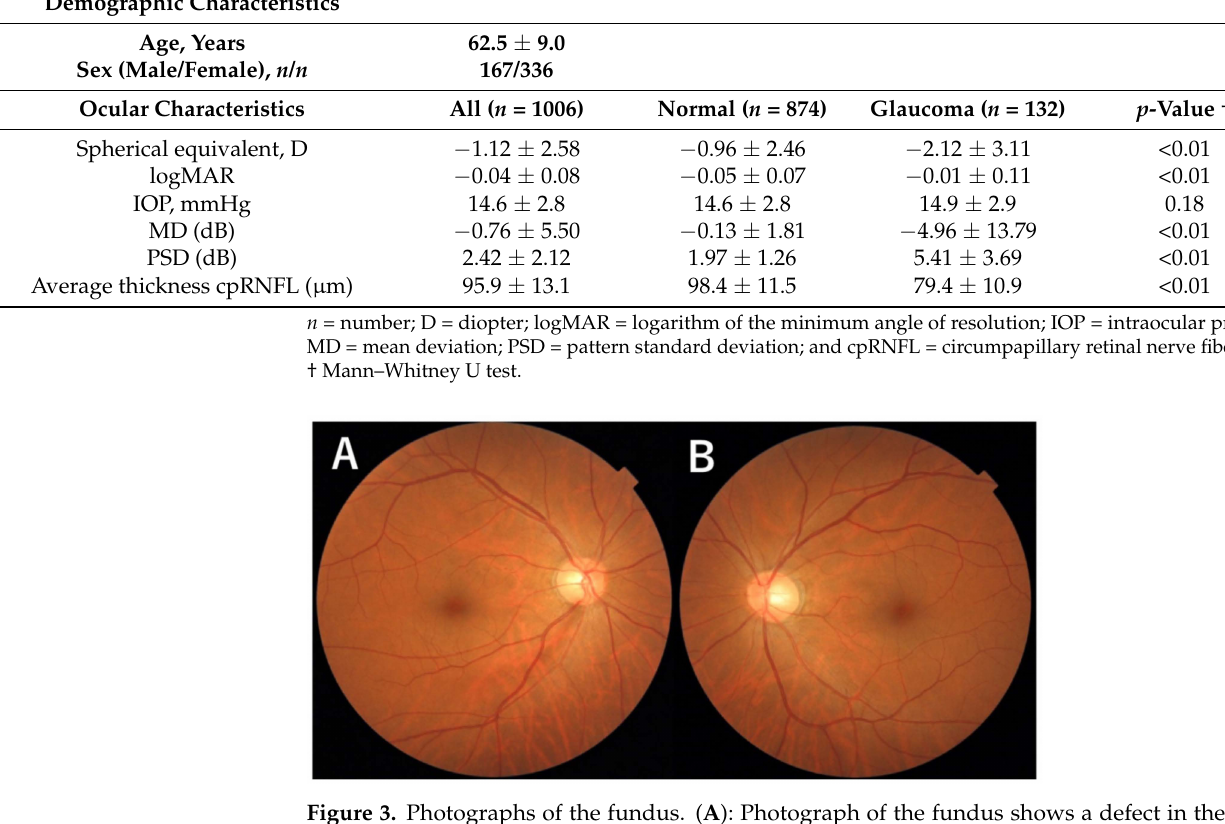
Figure 3. Photographs of the fundus. ( A ): Photograph of the fundus shows a defect in the nerve fiber layer located in the inferotemporal area in the right eye. Enlarged view of the optic disc at the 6 o’clock disc edge. ( B ): No abnormal findings in the left eye.